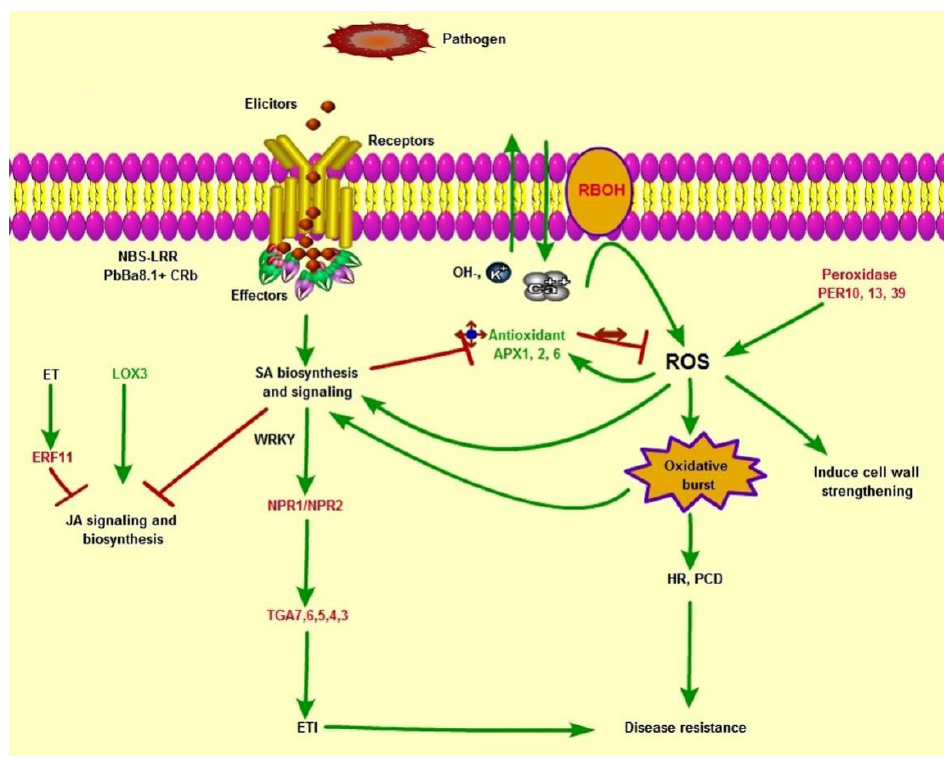
Figure 7. Schematic diagram showing the plant defense signaling network in B. napus resistance lines in response to P. brassicae. in response to P. brassicae